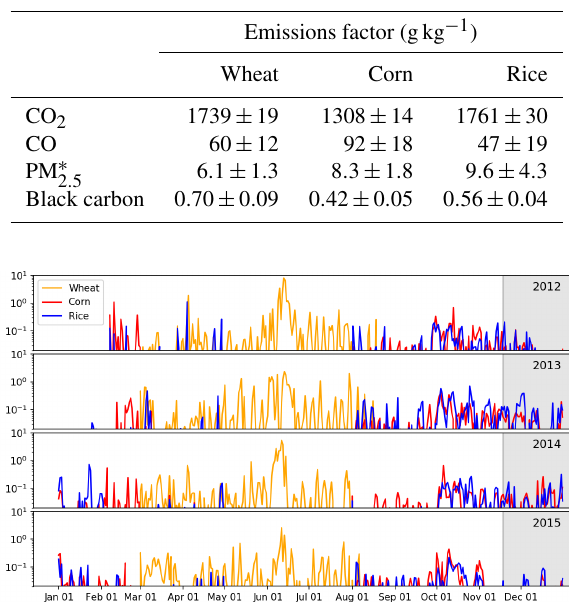
Table 1. Emission factors for agricultural residue burning used in this study. Wheat and rice emission factors were derived from field measurements conducted in eastern China and reported by Zhang et al. (2015), while the corn emission factors are from Andreae and Merlet (2001), the same as those used in the GFAS (Kaiser et al., 2012). ∗ PM 2 . 5 : particulate matter with diameter < 2 . 5µm.